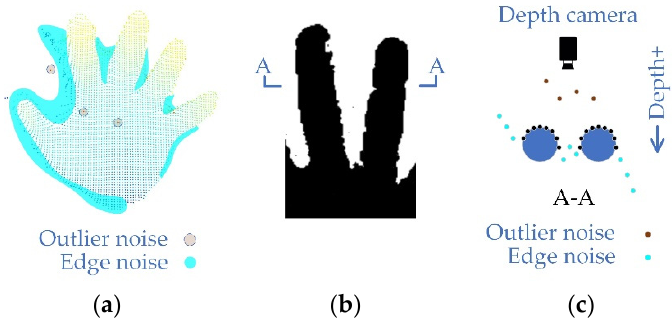
Figure 2. Noise classification. ( a ) A noisy point cloud image of the human hand at a distance of 800–900 mm. In order to show the details of the noise area, position A in ( b ) is cut and the section view is displayed in ( c ).